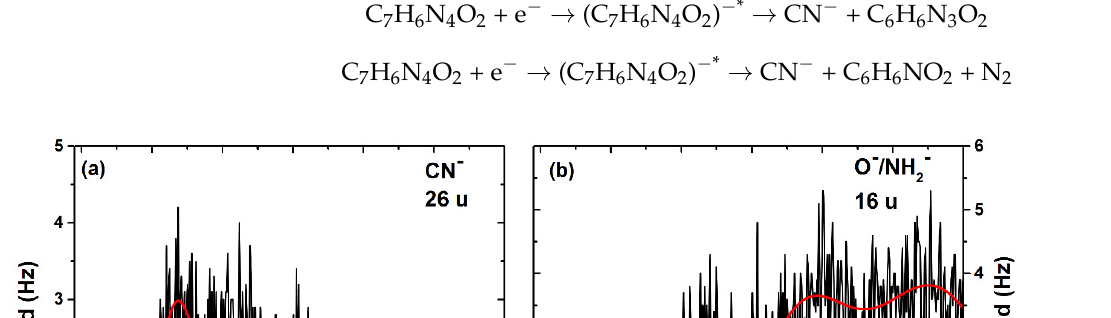
Figure 6. Anion efficiency curve for the formation of ( a ) CN − and ( b ) O − /NH 2 − upon electron attachment to TPZ.